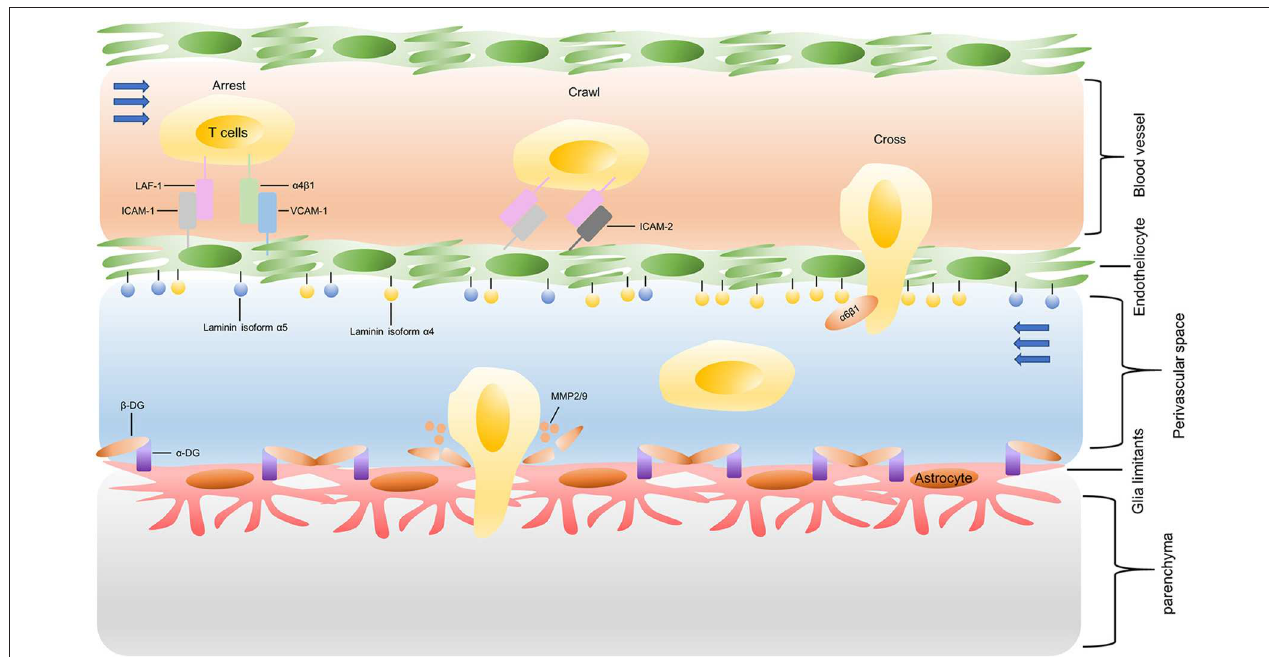
FIGURE 3 | Recruitment of infused T cells into GBM. LAF-1, lymphocyte-associated antigen-1; ICAM-1, intracellular cell adhesion molecule 1; VCAM1, vascular cell adhesion molecule 1; MMP: matrix metalloproteinases; β -DG: β